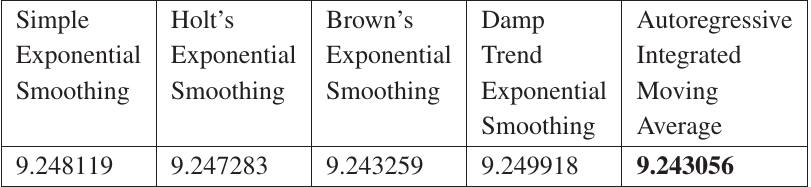
Table 4. MAPE comparison results for products in group